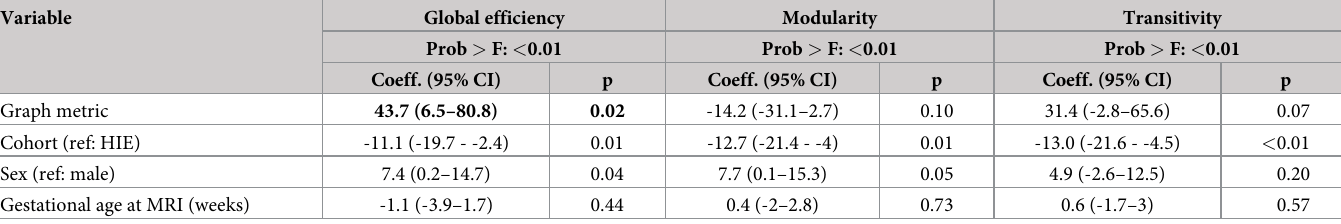
hypothesis-based and data-driven approaches. We found that the SLF 3 was negatively corre- lated with overall language function at 12–18 months and SLF 2 was negatively correlated with expressive language at 30 months. After controlling for multiple comparisons and gestational age at scan, we found a number of white matter tracts and regions of interest to be hypocon- nected in the CHD group compared with HIE. Among these are regions known to be associ- ated with language and visual function suggesting specific anatomical loci for deficits observed in children with CHD. Table 5. Multivariate analyses of motor